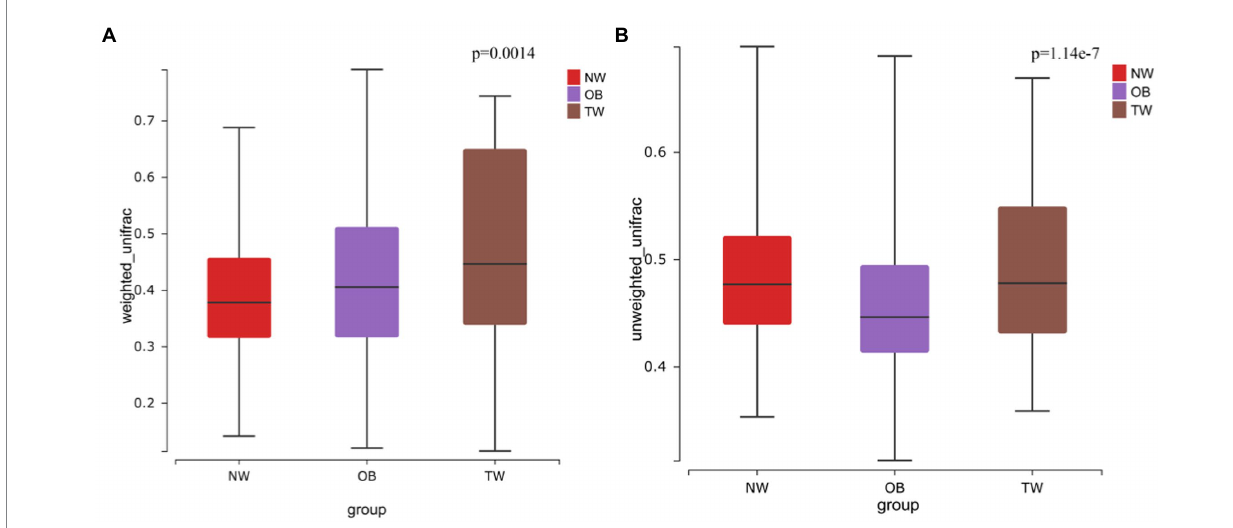
FIGURE 3 Beta diversity in three groups. (A) Beta diversity in the case of weighted species taxonomic abundance information; (B) Beta diversity in the case of weighted species taxonomic abundance information. The value of p s for comparisons are shown above the boxes. Kruskal–Wallis was used to test for significant differences in beta diversity.